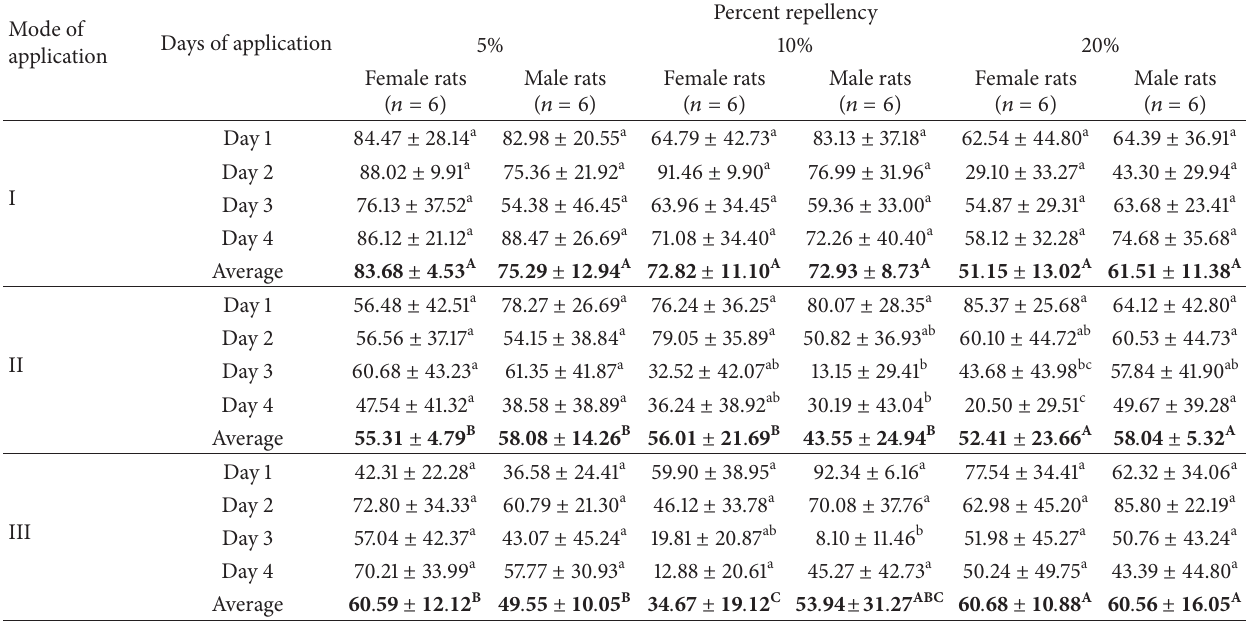
Values are mean ± SD, I = daily, II = once a week, and III = alternatively. Values with similar superscripts in the column for four days (a or b) and for average values (A, B, or C) at each mode of application indicate no significant difference in percent repellency. Values with different superscriptsinarowforfourdays(a-b)andforaveragevalues (A–C)ateachmodeof applicationindicatesignificant differenceinpercent repellency between the two sexes at 𝑃 ≤ 0.05 .